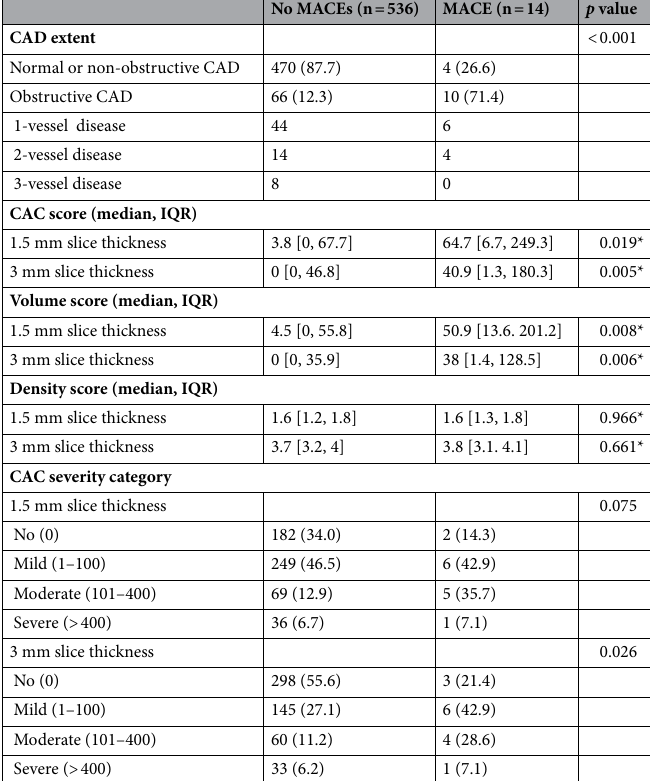
Table 3. CAD severity, CAC score, volume score, density score. and CAC severity category for individuals with or without MACEs. Data expressed as number (percentage). CAD Coronary artery disease, CAC Coronary artery calcium, IQR Interquartile range. *Wilcoxon’s singed rank